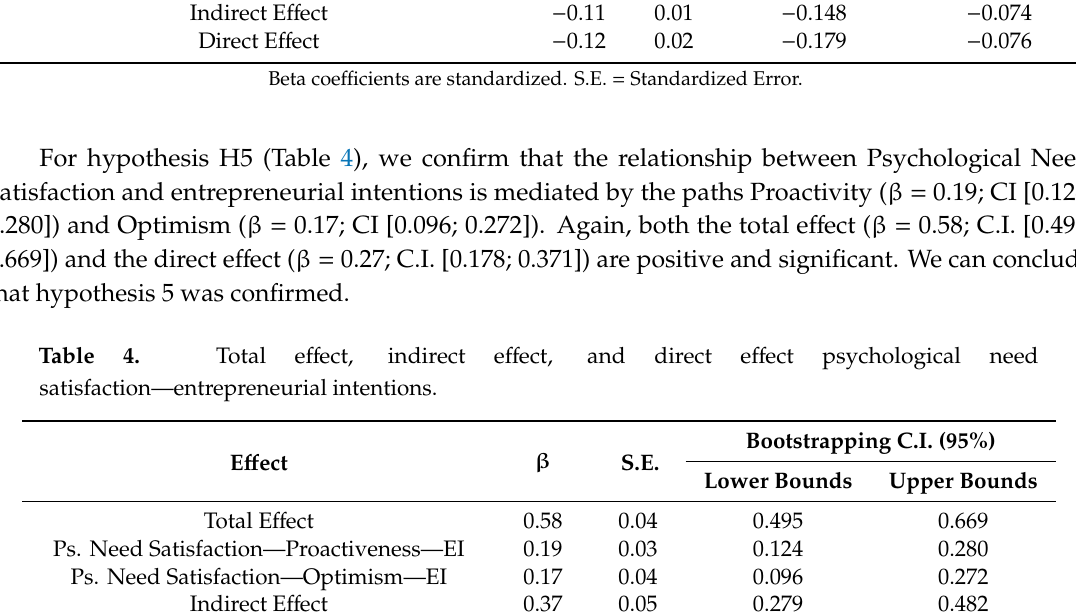
Bootstrapping C.I. (95%) Lower Bounds Upper Bounds